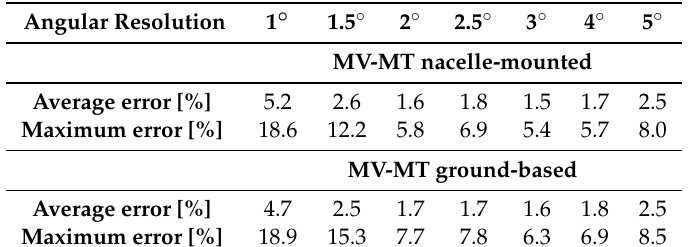
Table 4. Example of optimization of the angular resolution for one inflow case and both lidar locations. The table presents the average and maximum total errors for the reconstruction of the average longitudinal velocity component inside the volume of interest. The errors are shown as a percentage of the undisturbed wind speed at hub height (see Section 2.1.3).